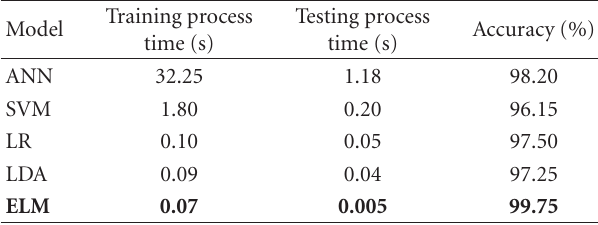
Table 1: Performances of the ANN, SVM, LR, LDA, and ELM learn- ing